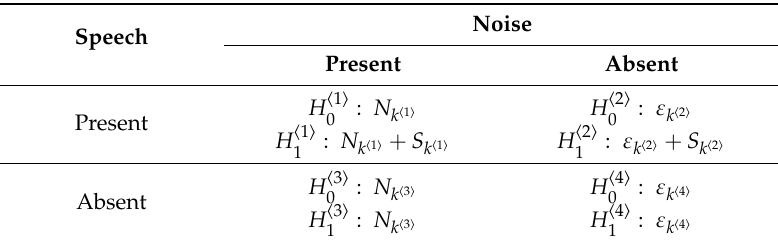
Table 1. Four sparseness states of H 0 and H 1